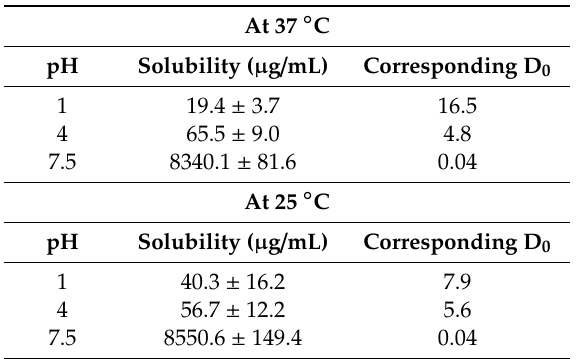
Table 1. Furosemide solubility values ( µ g / mL) at the tree pH values 1.0, 4.0, and 7.5, at 37 ◦ C (upper panel), and at room temperature (25 ◦ C; lower panel), as well as the corresponding dose number (D 0 ) calculated for an 80-mg dose. Data presented as mean ± SD; n =